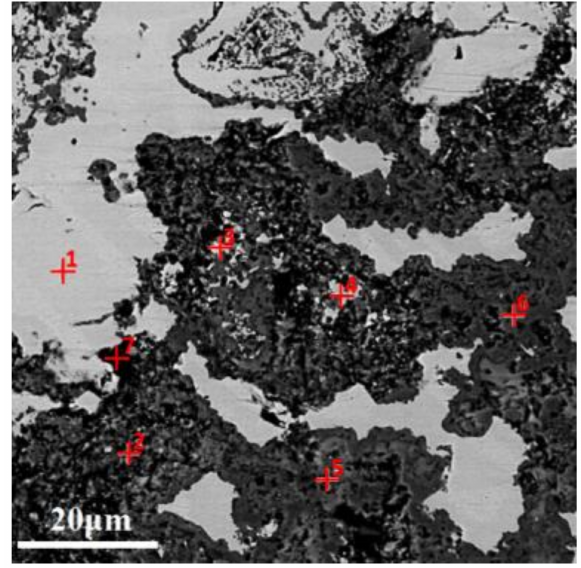
Figure 7. SEM images of the top